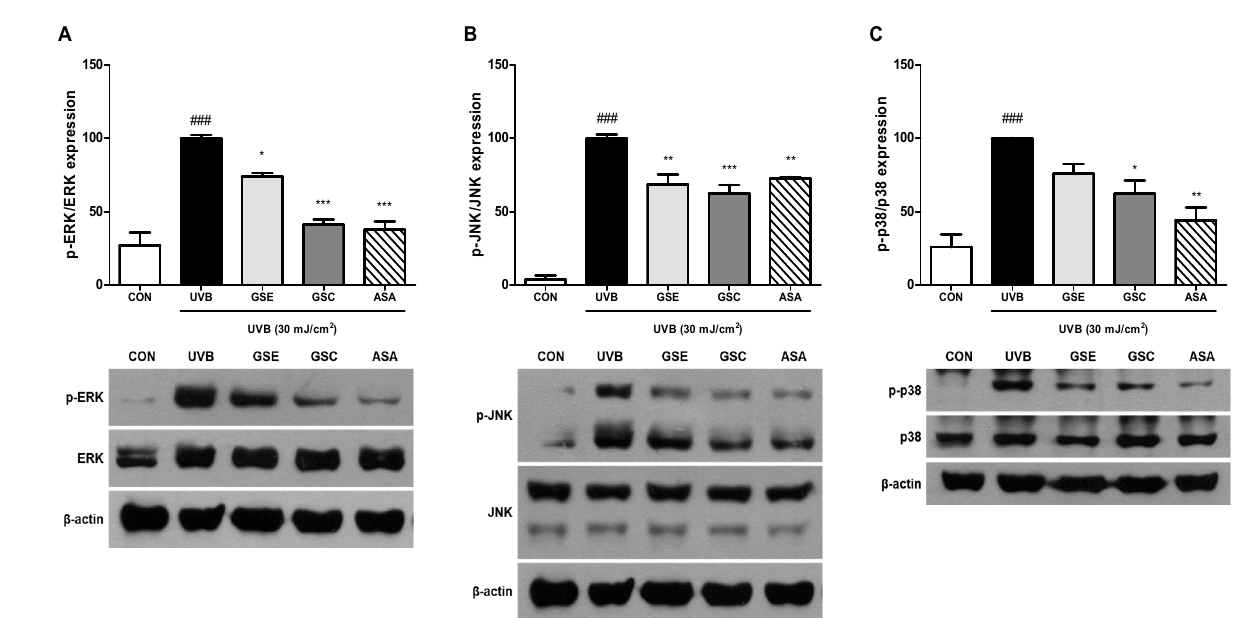
Figure 3. Effects of ginseng seed embryo (GSE) and coat (GSC) on the phosphorylation of mitogen activated protein kinase (MAPK) proteins in UVB-irradiated Hs68 cells. Control or UVB-irradiated cells were treated with/without GSE or GSC and subjected to western blotting for ( A ) p-ERK, ( B ) p-JNK, and ( C ) p-p38 levels. The relative levels of the phosphorylated proteins were normalized to those of the respective total MAPK proteins. Values are expressed as the mean ± standard error ( n = 3). ### p < 0.001, significant difference compared to control; *, **, and *** p < 0.05, 0.01, and 0.001, respectively, significant difference compared to UVB-irradiated group. ASA (ascorbic acid, 100 µ M), positive control.